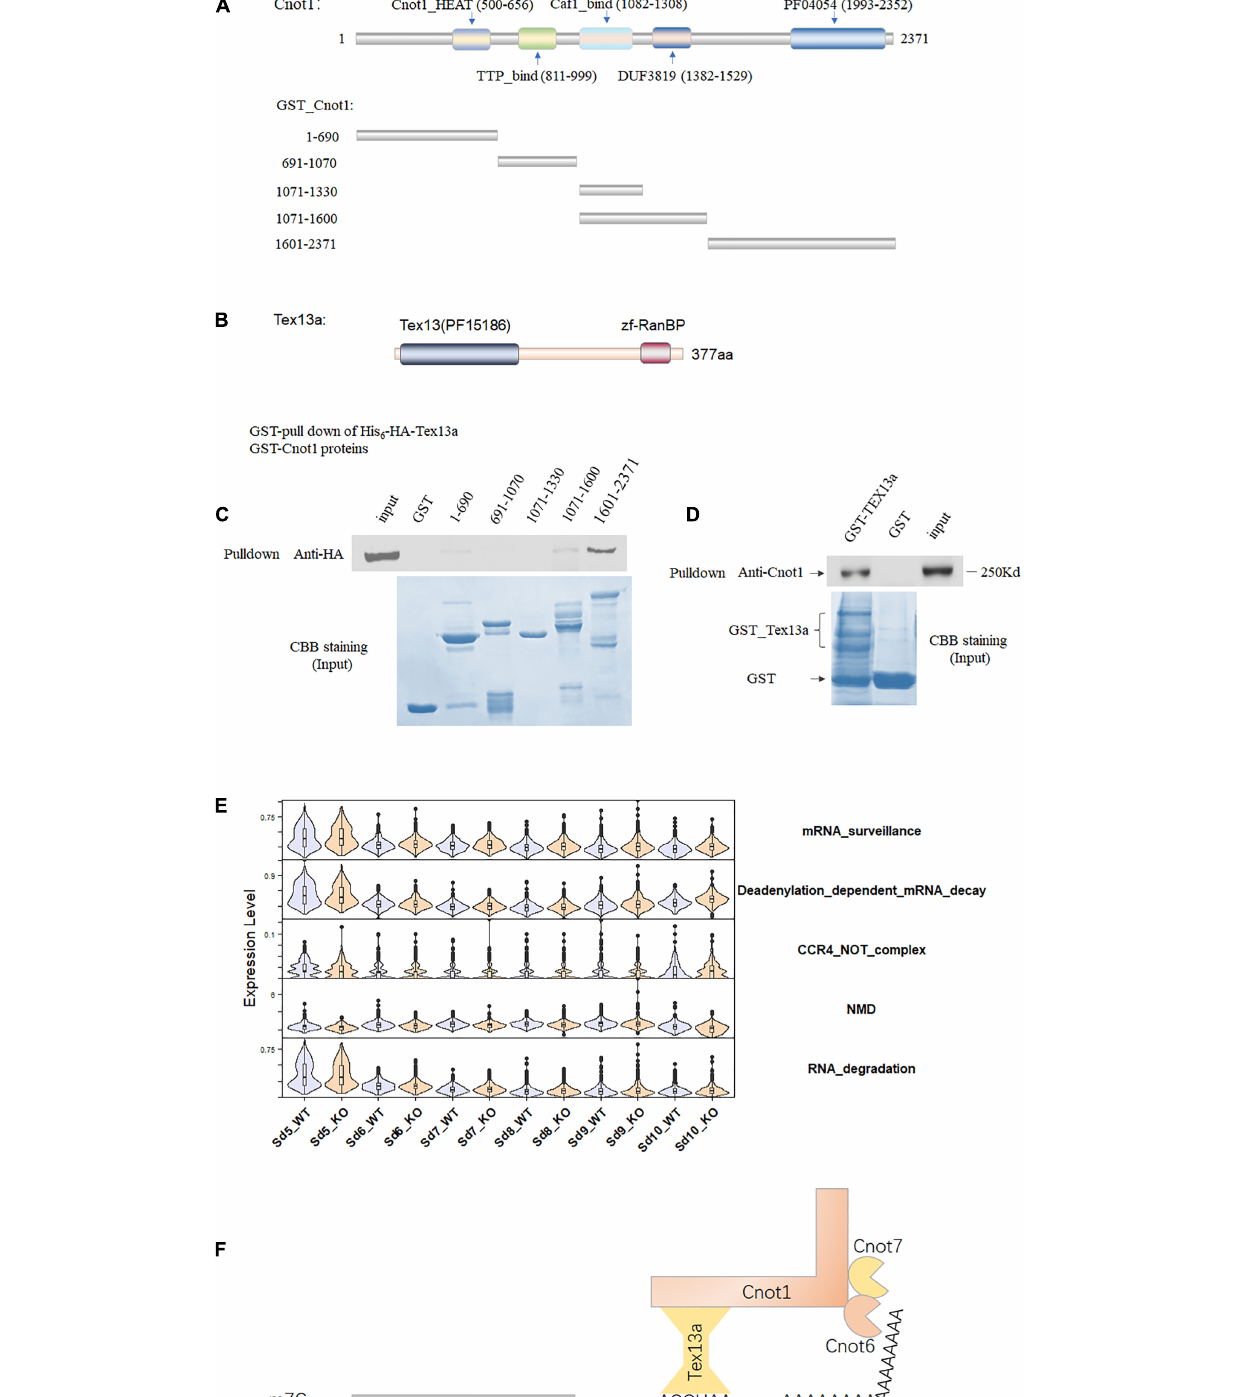
Frontiers in Cell and Developmental Biology |